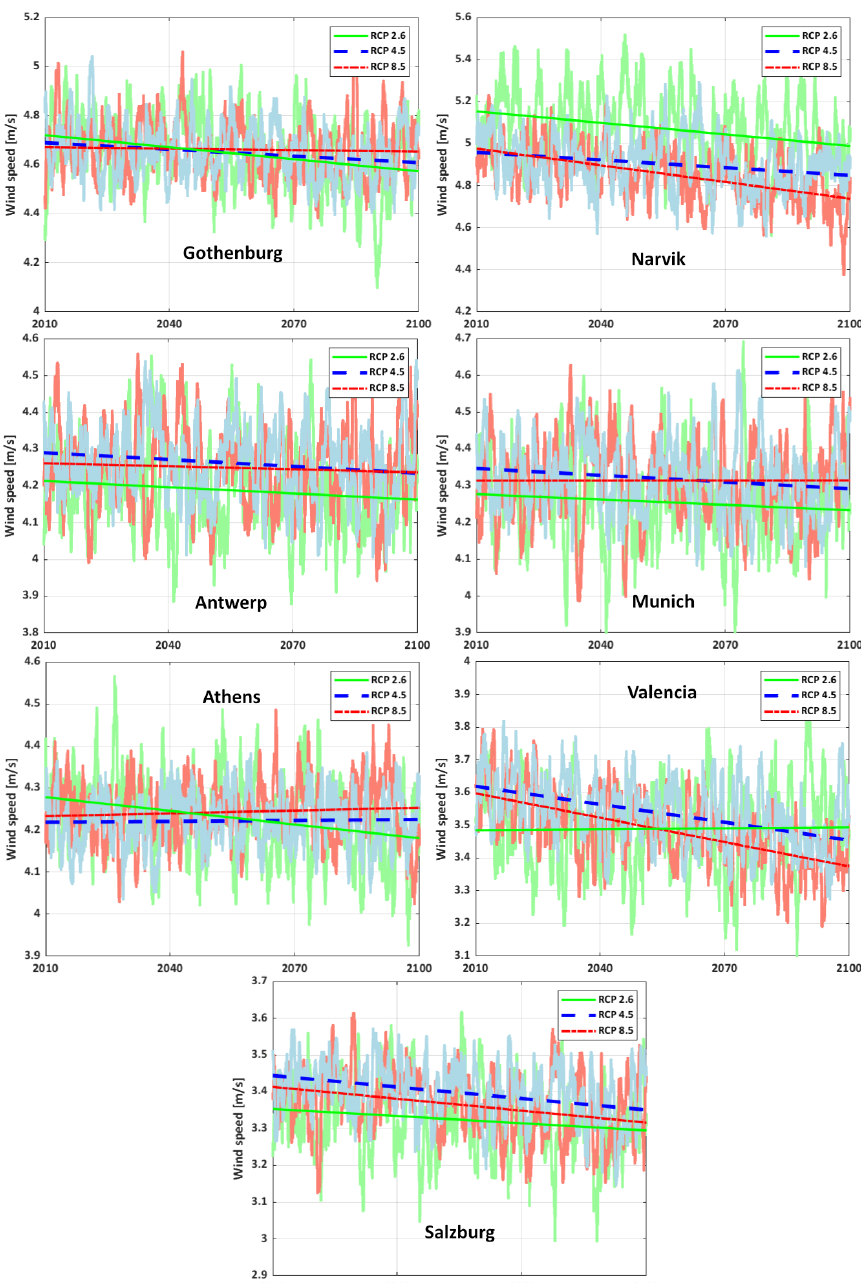
Figure 2. Wind speed trend regression analysis for RCP 2.6 (green), RCP 4.5 (blue), and RCP 8.5 (red) in seven cities during the period of 2010–2100 considering five GCMs.